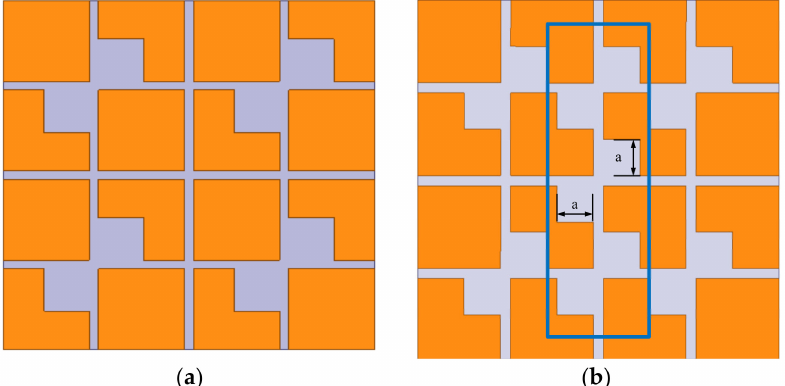
Figure 4. Geometry of the metasurface with ( a ) four parasitic square cross gaps; ( b ) seven parasitic square cross